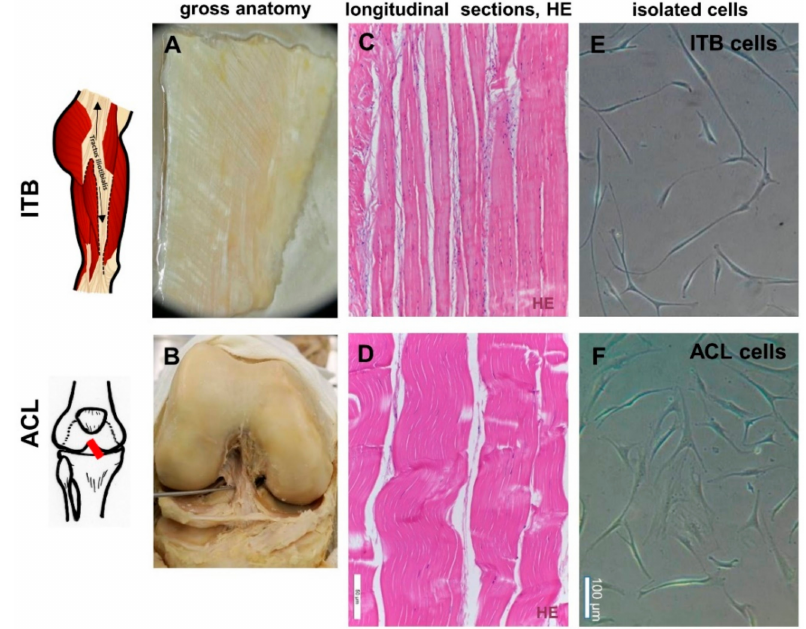
Figure 1. The gross anatomy, histology, and isolated fibroblasts of iliotibial band (ITB) and anterior cruciate ligament (ACL) tissue: The gross anatomy of ITB ( A ) and ACL ( B ) tissue. The hematoxylin and eosin (HE) staining of ITB ( C ) and ACL ( D ) tissue. Fibroblasts isolated from ITB ( E ) and ACL ( F ) tissues. Scale bars: 50 µ m (Figure 1C,D) and 100 µ m (Figure 1E,F). ITB: iliotibial band, ACL: anterior cruciate